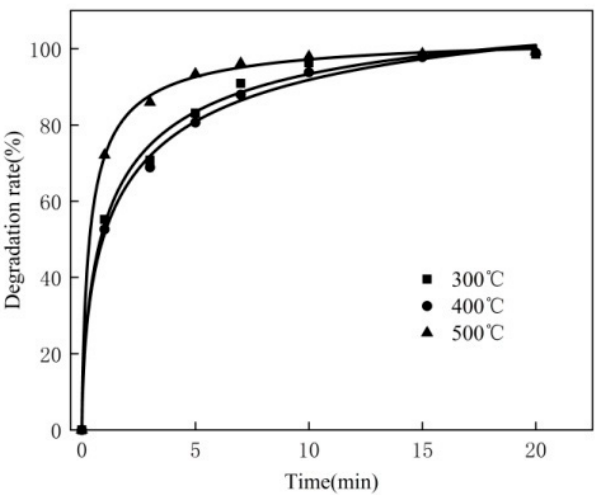
Figure 6. Effect of calcination temperature.